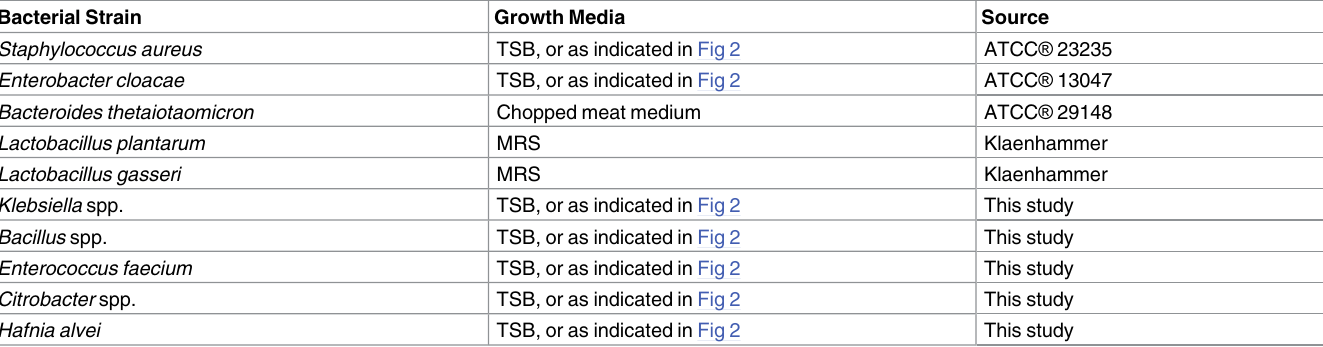
Table 1. Bacterial strains and growth media used in this